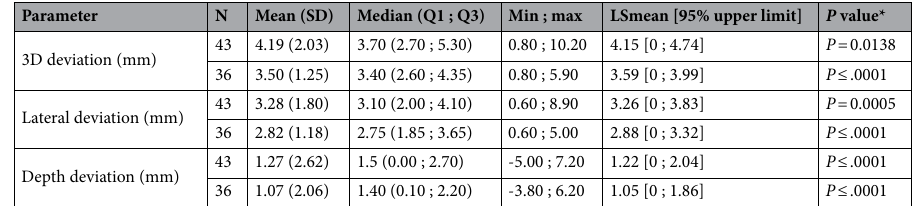
Table 2. Needle placement accuracy (in mm)—Summary table of 3D, lateral and depth deviations-All operators. Analyses based on all or last needle insertion measure. * P value for